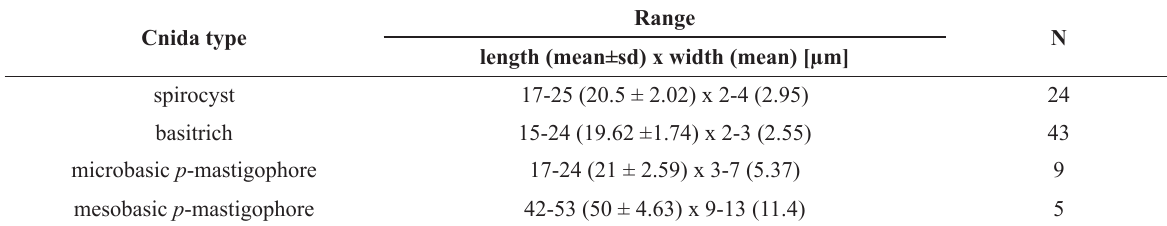
Cnidom of planula larvae of Aulactinia marplatensis.